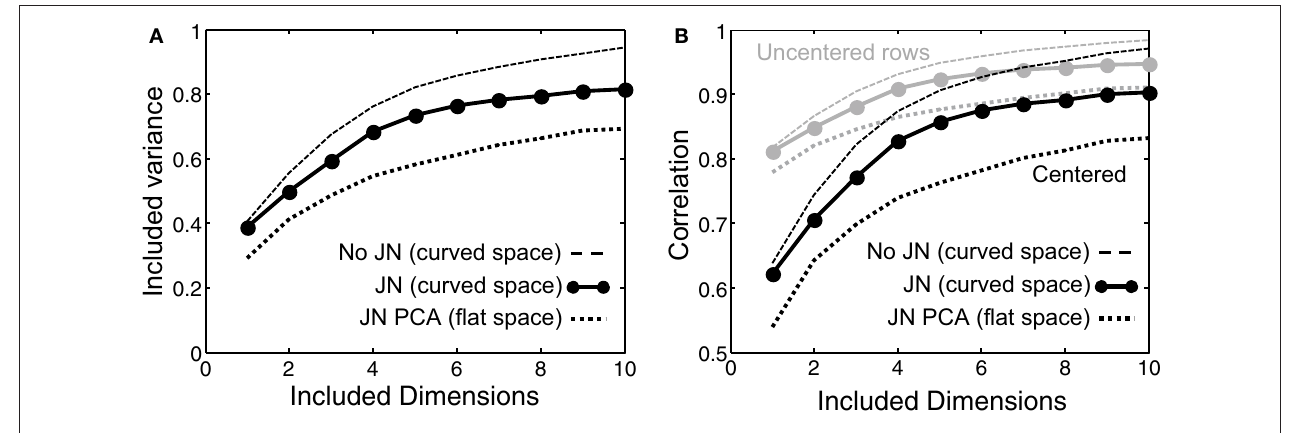
Figure 4 | Approximation of perceptual responses with spaces of small dimensionality. To avoid overfitting we applied the jackknife (JN) technique. Results for the best curved/flat spaces are shown by solid/dotted lines as a function of the number of dimensions included. The flat space technique is